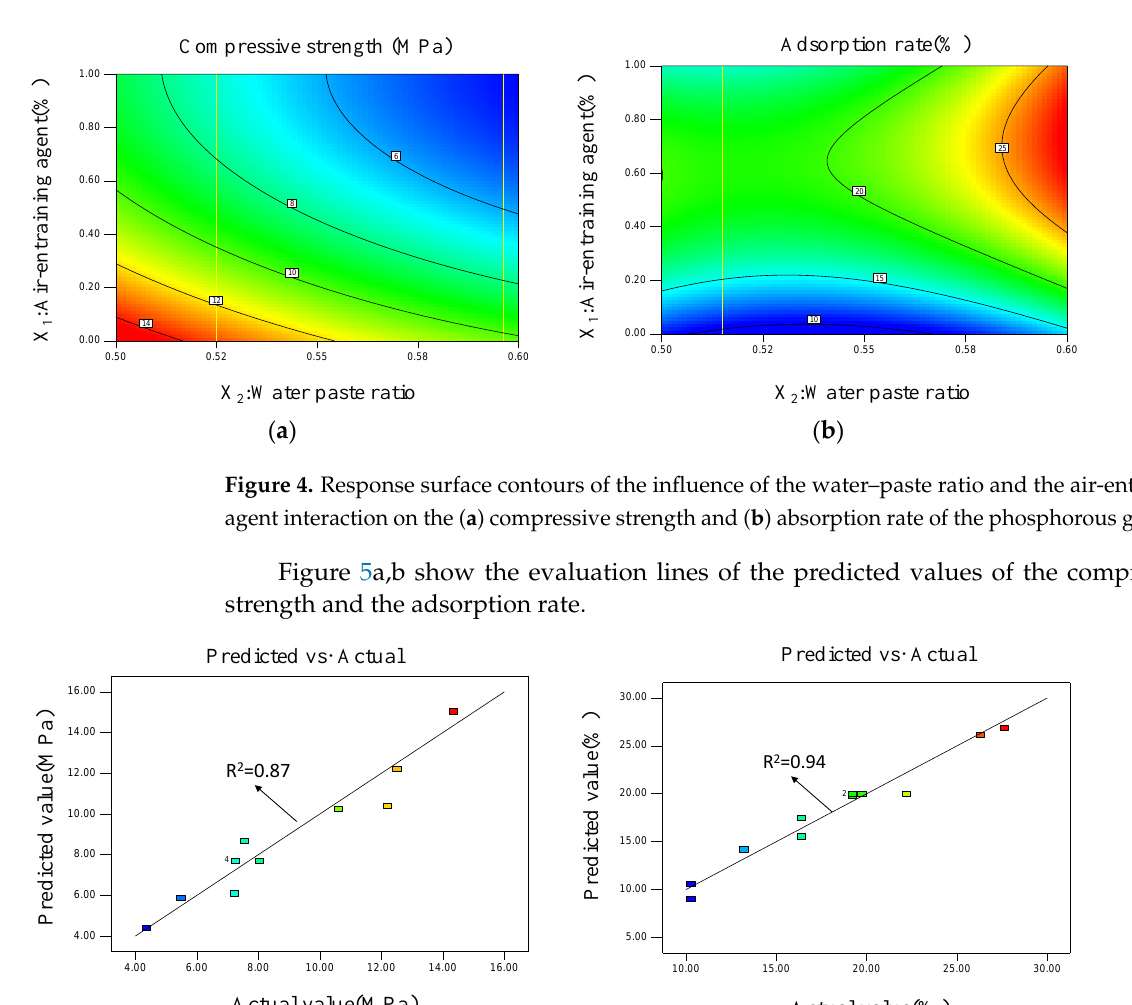
Figure 3. Response surface curves of the influence of the water – paste ratio and the air-entraining agent interaction on the compressive strength and adsorption rate of the phosphorous gypsum: ( a ) compressive strength and ( b ) adsorption rate response surface curves.